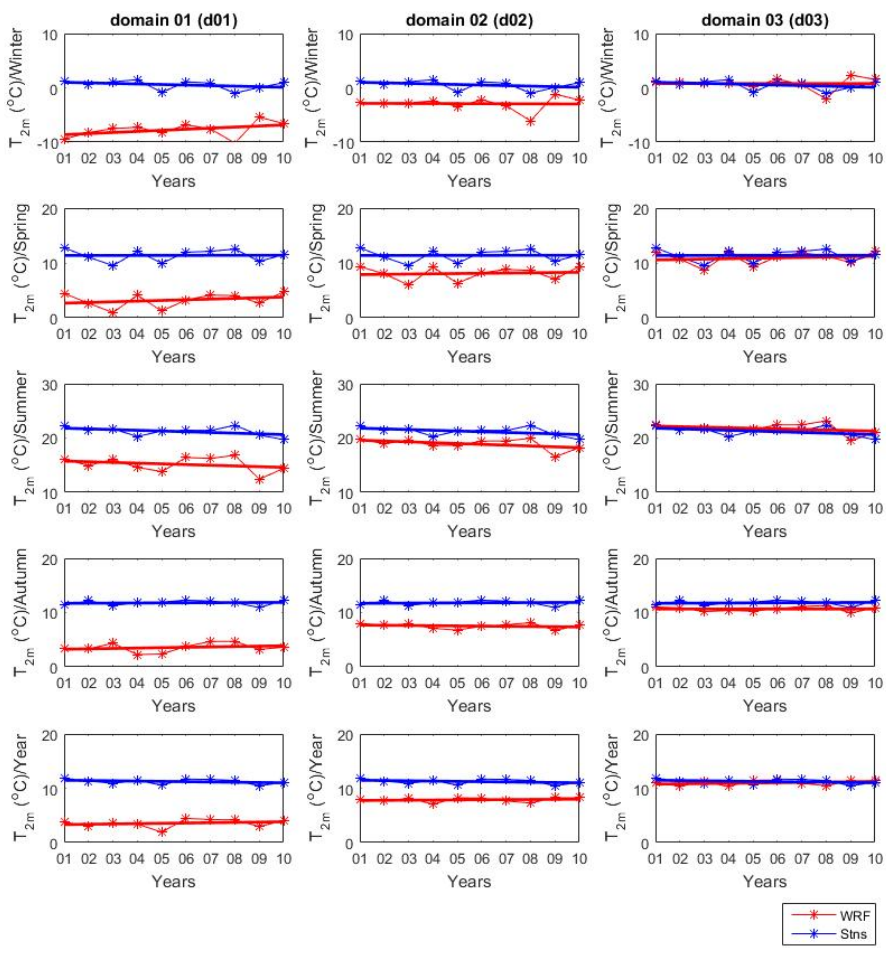
Figure 3. Time series comparisons of temperature (T2) between WRF (red) and the mean of stations (“Observed”; blue) in d01 (left column), d02 (middle column), and d03 (right column) with lapse rate correction. From top to bottom, the five rows correspond to winter (DJF), spring (MAM), summer (JJA), autumn (SON), and annual. The straight lines are least ‐ squares linear regressions.